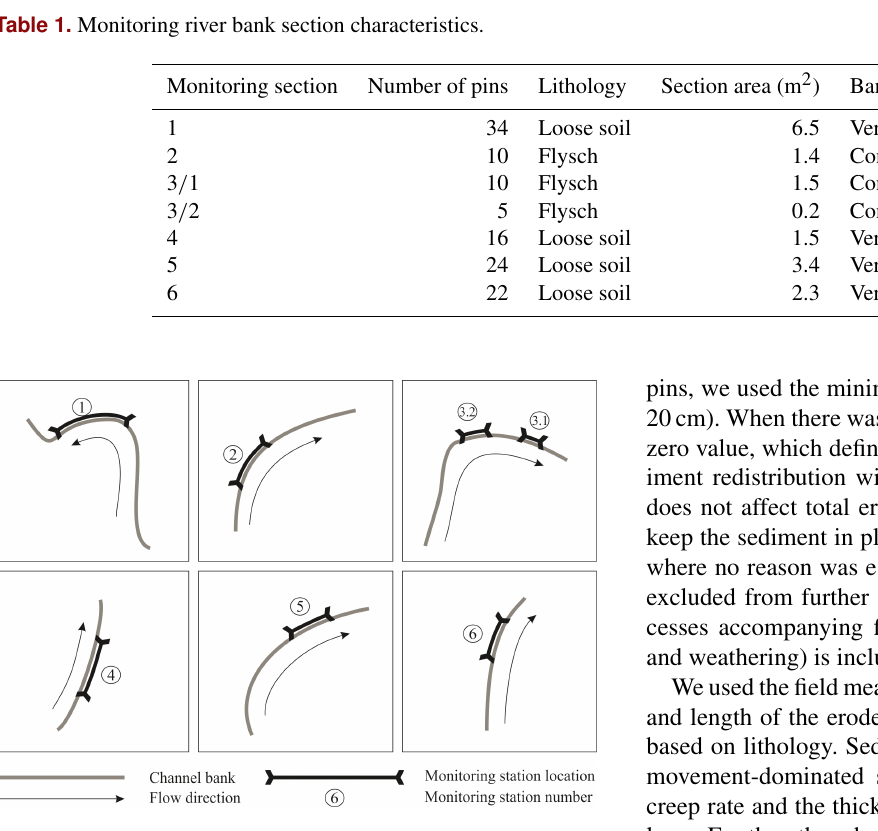
Figure 3. Locations of monitoring sections on the river banks rela- tively to flow